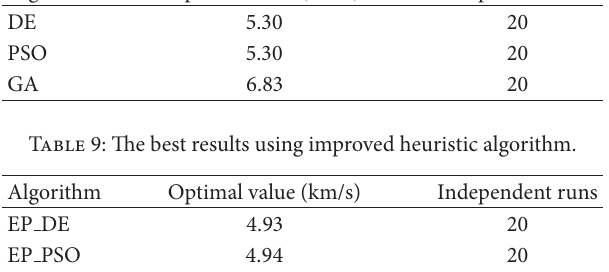
Table 8: The best results using DE, PSO, and GA. Algorithm